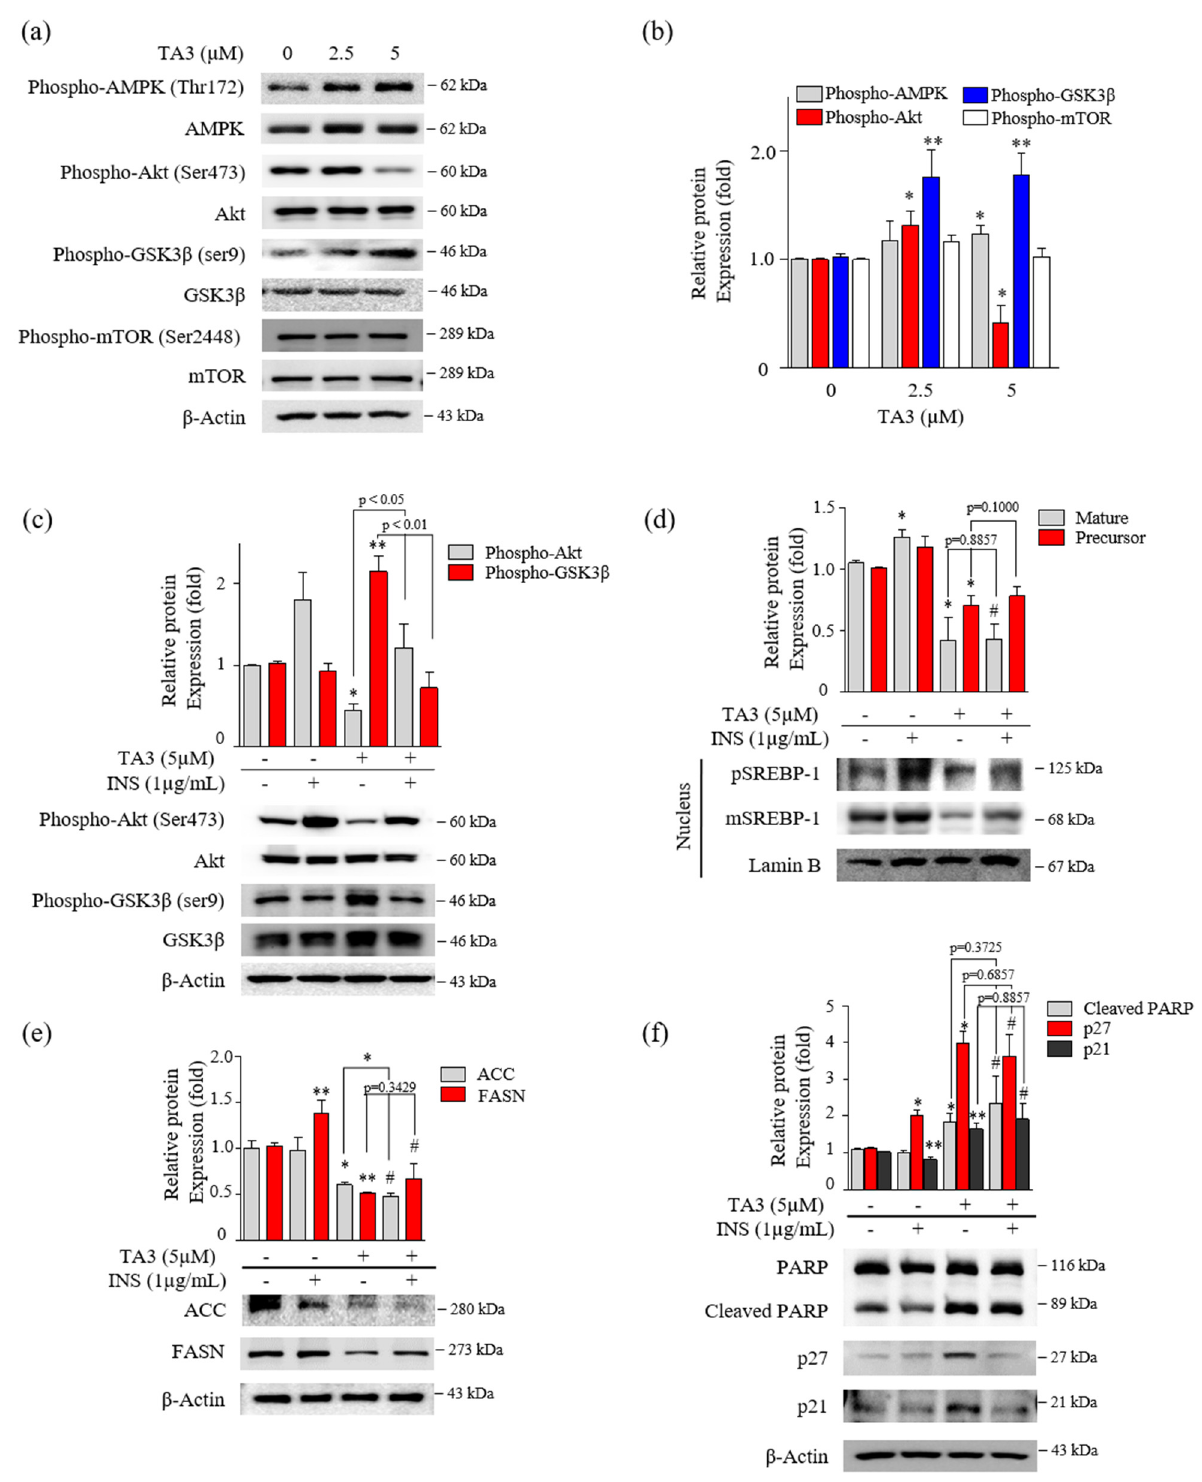
Figure 4. Inhibition of SREBP-1 expression by TA3 was independent of Akt and Gsk3 β regulation. ( a ) The regulation of AMPK, Akt, Gsk3 β , and mTOR expression on BxPC-3 cells treated with TA3 for 12 h. ( b ) Immunoblotting results are presented in the bar graph as fold changes compared with that of the control as the mean ± SD of three independent experiments. ( c – f ) Activation of proteins was induced by insulin and compared with/without TA3 treatment. After 12 h, extracted proteins were analyzed using immunoblotting, and the expressions of proteins were observed using ( c ) Akt